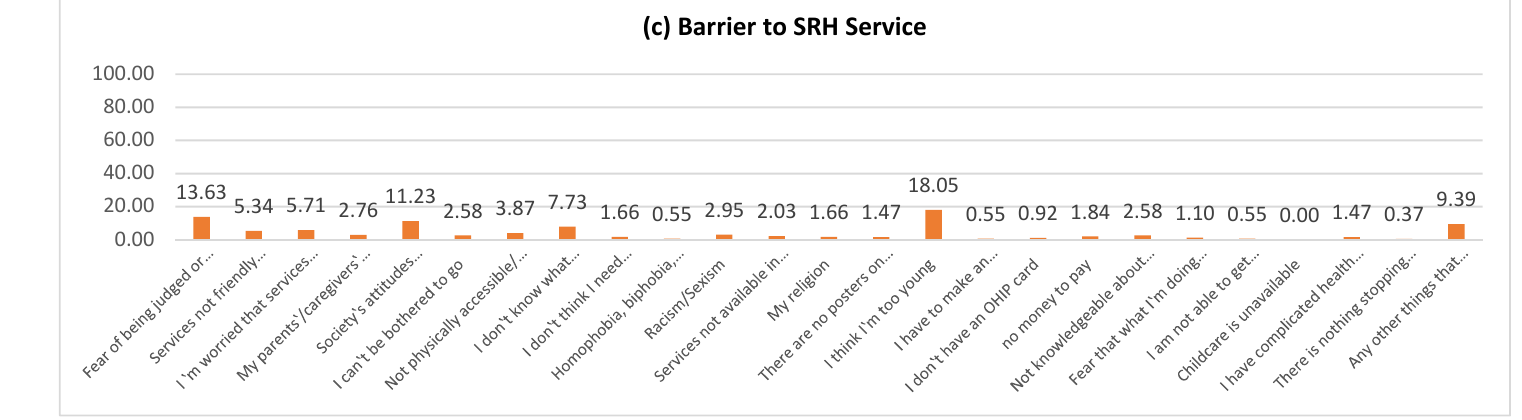
Figure 2. Adolescents SRH services utilization.